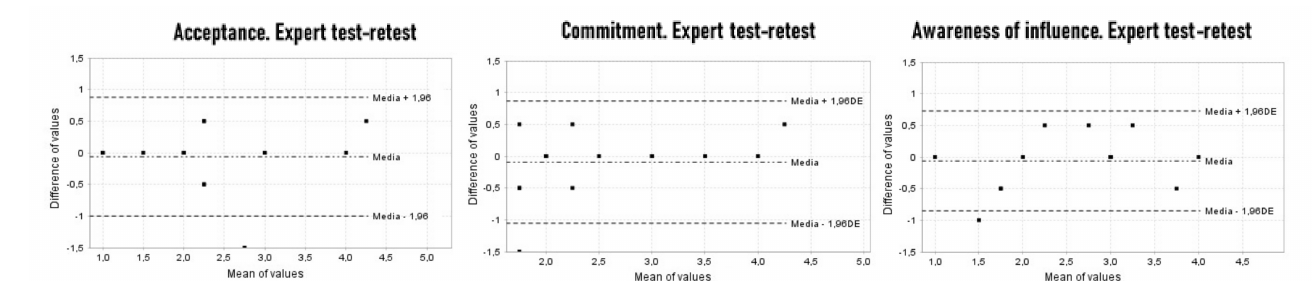
Figure 2. Intra-rater reliability (Bland-Altman